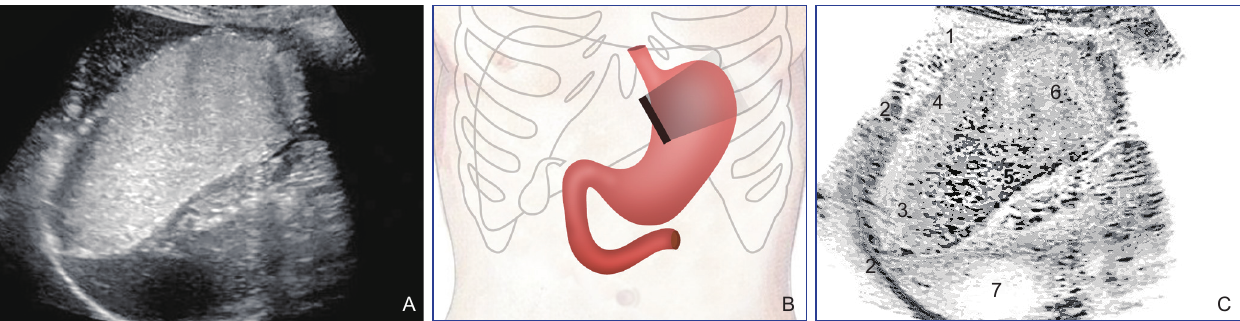
Figure 6 Ultrasonic images of long axial section of the gastric fundus and schematic diagram of the section (scanning under xiphoid process). A, Ultrasonic image; B, Scan the schematic diagram; C, Ultrasound schematic diagram (1, Left lobe of liver; 2, Left diaphragm; 3, The gastric fundus; 4, Anterior wall of the stomach; 5, Posterior wall of the stomach; 6, Stomach; 7, Spleen)